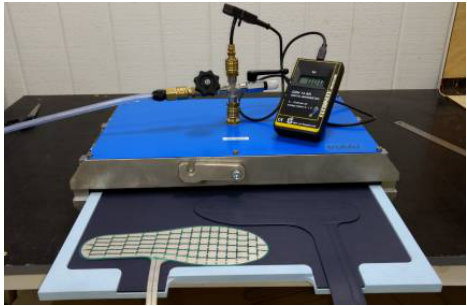
Figure 1. Calibration process: SI (left) and PE (right) systems placed inside a calibration